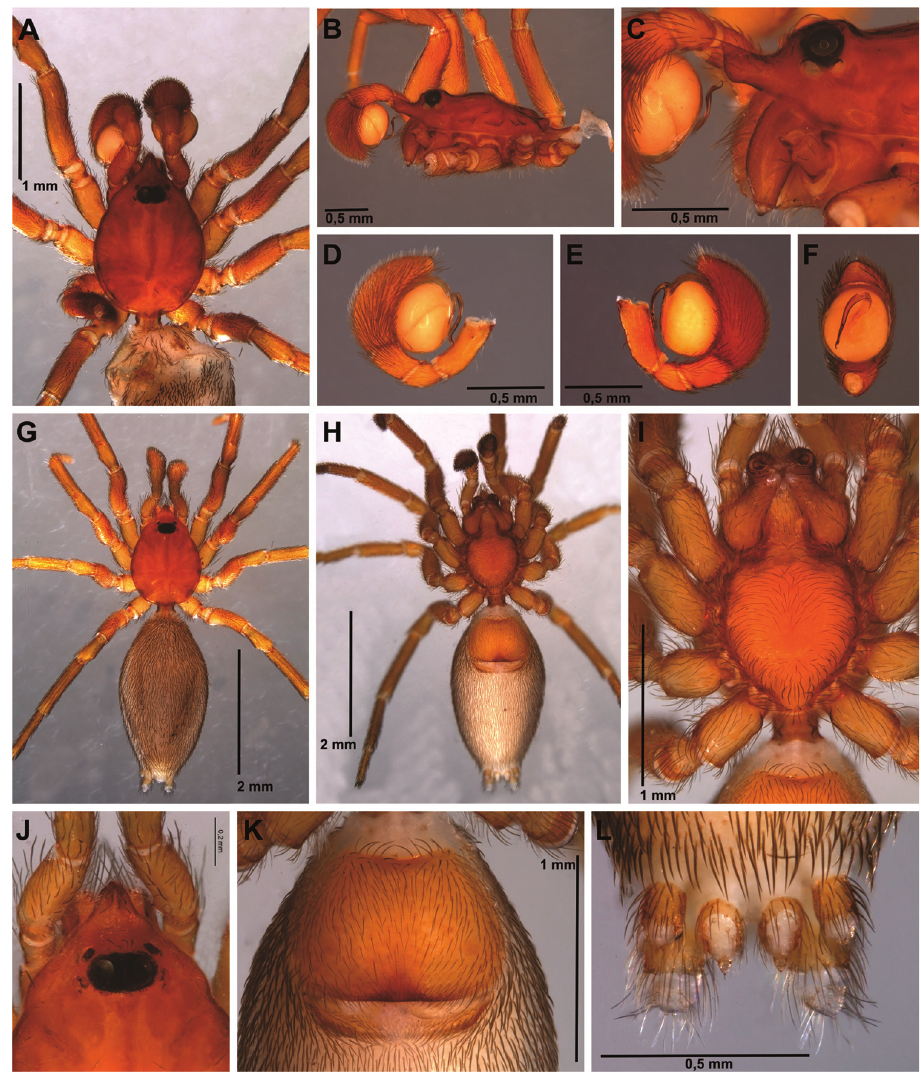
Figure 8. Nasutonops xaxado sp. n., male from Serra Talhada, Pernambuco ( A–F ) female, same locality ( G–L ) A habitus, dorsal view B carapace, lateral view C ocular area, lateral view D left pedipalp, pro- lateral view E same, retrolateral view F same, ventral view G habitus, dorsal view H same, ventral view I carapace, ventral view J ocular area, dorsal view K genital area, ventral view L spinnerets, ventral view. Male (Holotype). Total length 3.80, with clypeal horn. Carapace 1.7 long, 1.2 wide. Coloration: carapace orange-reddish, except apex of endites and labium white, legs and palps orange. Eye median diameters 0.3, interdistances 0.15. Leg measure- ments: I: femur .1.1/ patella 0.5/ tibia 0.8/ metatarsus 0.7/ tarsus 0.4/ total 3.5; II: 1.1/ 0.5/ 0.7/ 0.7/ 0.4/ 3.4; III: 0.9/ 0.5/ 0.6/ 0.6/ 0.5/ 3.1; IV: 1.1/ 0.6/ 1.0/ 0.9/